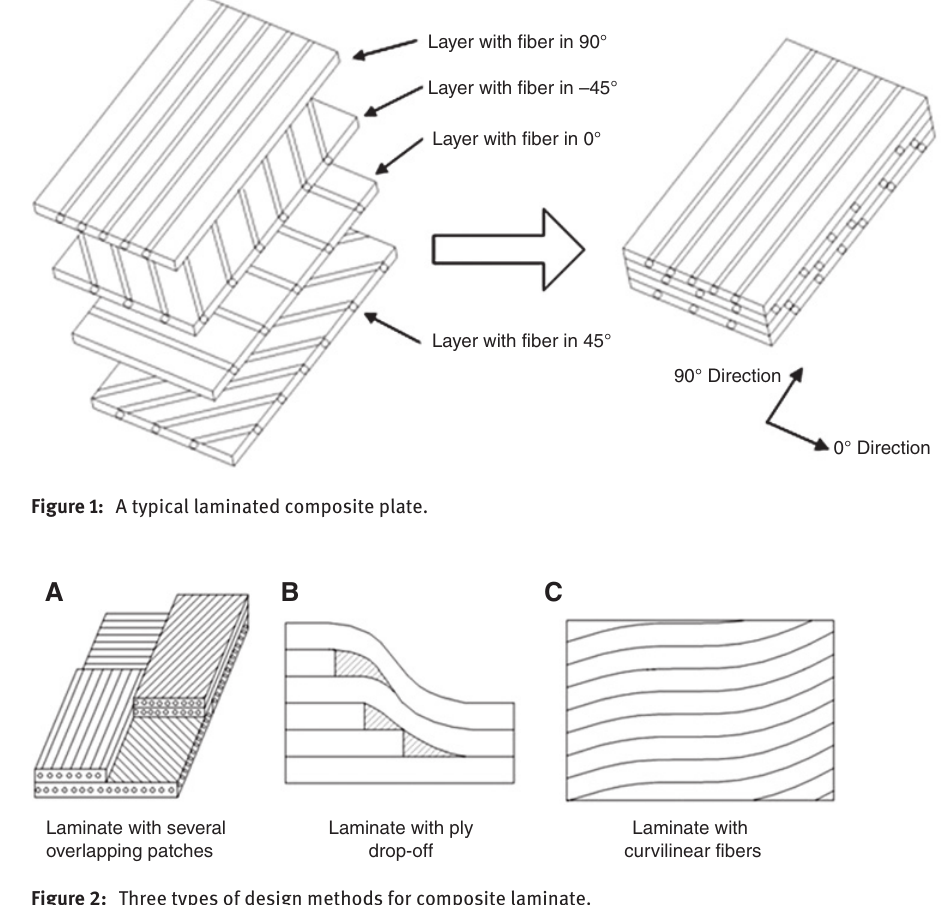
Figure 2: Three types of design methods for composite laminate. (A) Laminate with several overlapping patches. (B) Laminate with ply drop-off. (C) Laminate with curvilinear fibers.